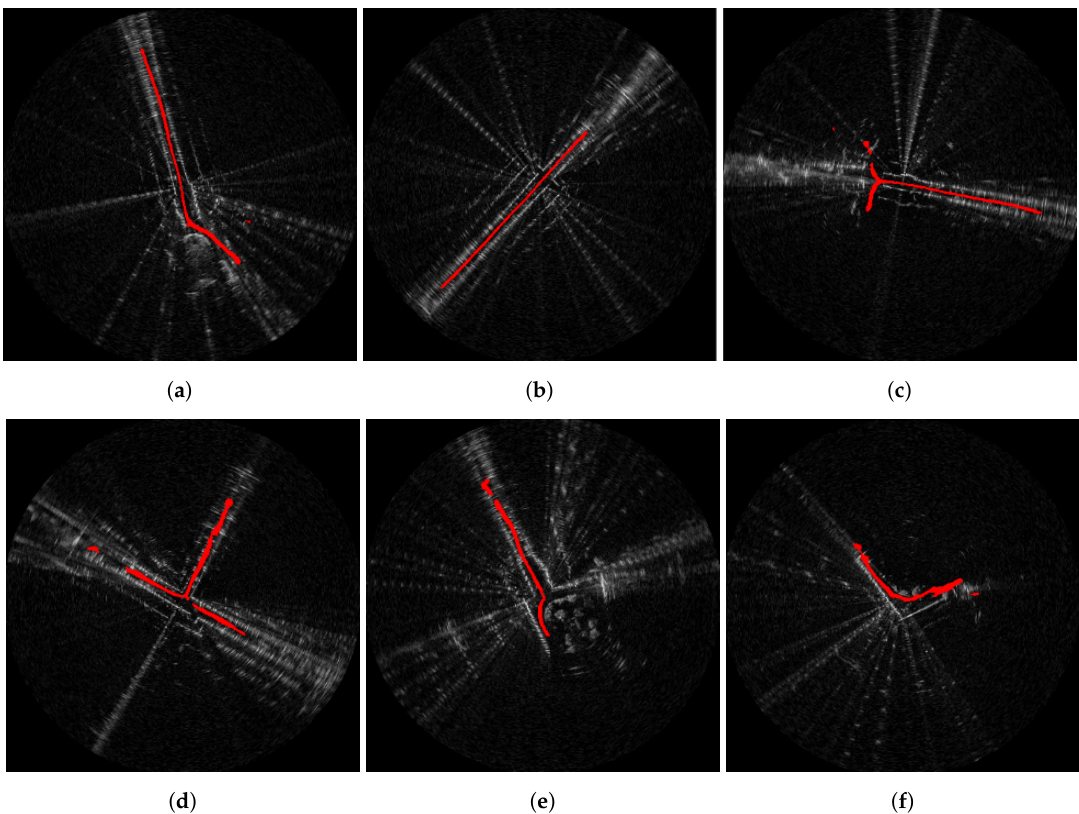
Figure 18. A sample of routes proposed for several different urban settings. The model deployed here was trained using traversability maps as well as route labels (c.f. L 1 and L 2 in the learned objectives of Section 4.2.2). The proposed routes are seen to outperform those presented in Figure 17. As compared to Figure 18a, the proposed vehicle track of ( a ), is more consistent in width. In ( a , e ) an obstacle ahead of the vehicles trajectory is understood to be non-traversable, and routes to the left or right of this feature are proposed. In ( b ), the vehicle drives along a narrow urban canyon, and no turns off of this route are seen as possible. In ( c ), the model admits for a left or right turn at the end of a narrow urban canyon. In ( d ), the model understands that a right turn off of the current path is feasible. In ( f ), the vehicle is circumnavigating a walled off park, and the turn out of this urban feature is not yet visible. Please see Section 6.2 for further discussion.